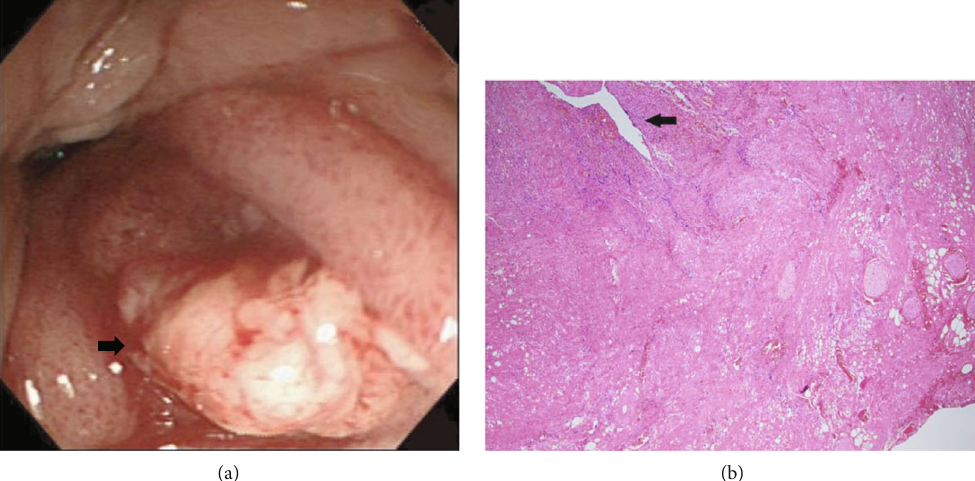
Figure 6: (a) Collapsed lumen with ulcerated mass obstruction over the infrapapillary area (arrow). (b) Transmural fi stular tract (arrow) in the third portion of the duodenum with perforation and in fl ammation (H&E, 40x).